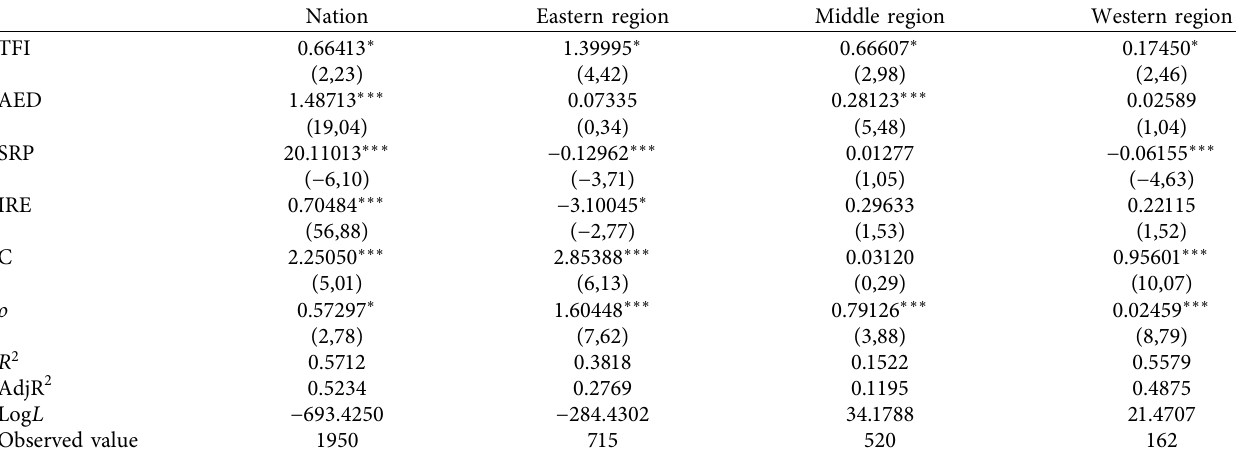
Table 5: Estimated results of the national sample and regional samples.